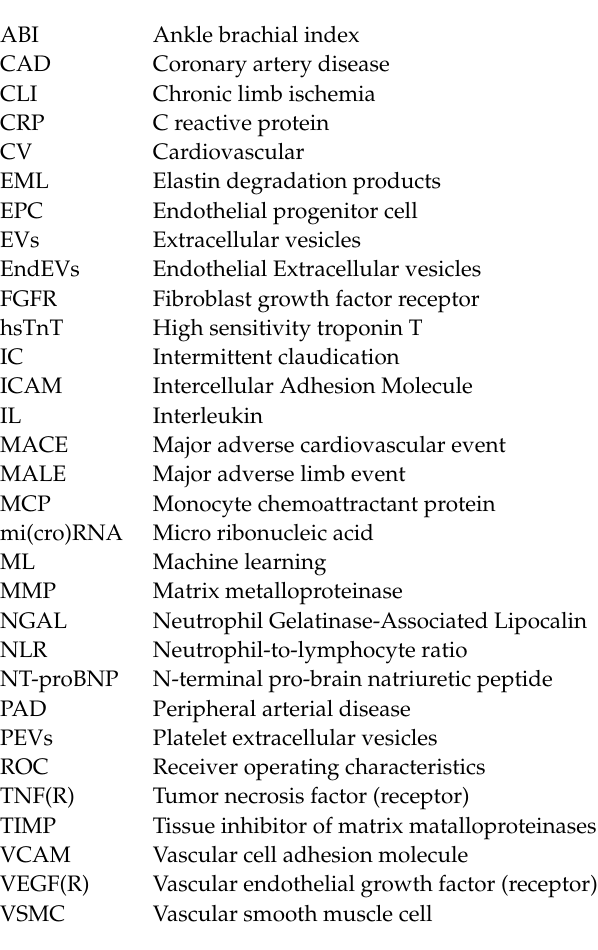
table designing E.M.-A., J.O., A.G.M. and C.R.; review and editing G.S.-P., E.M.-A., J.O.,